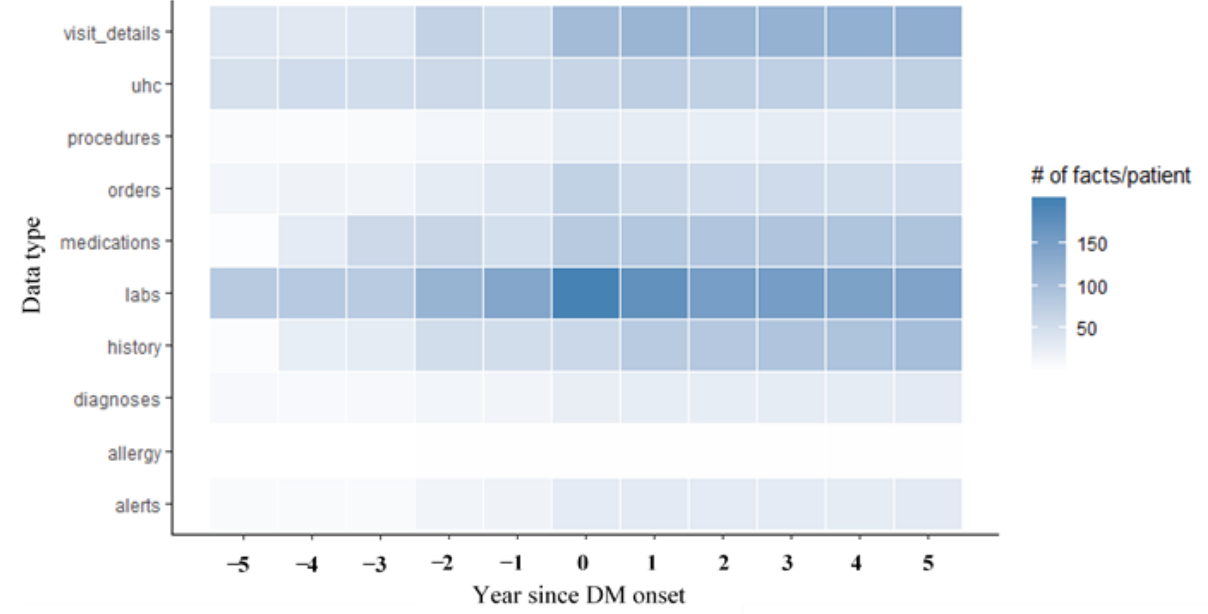
Figure 2. Clinical feature densities across data types. Each row corresponds to the average number of distinct clinical facts per patient for a certain type of clinical data over 5 years before and after DM onset. The darker the region is, the more distinct facts have been recorded for patients on average within the corresponding time window. DM: diabetes mellitus; UHC: University HealthSystem Consortium.